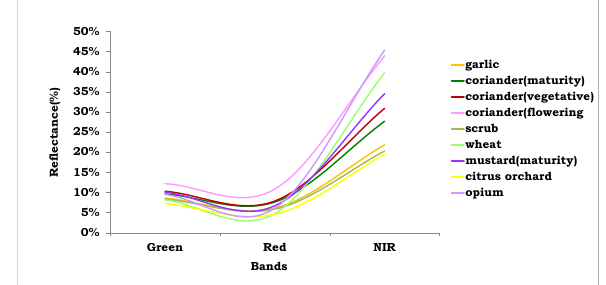
Figure 7. Feature Space plot of Red and NIR with 95 percent confidence ellipse.